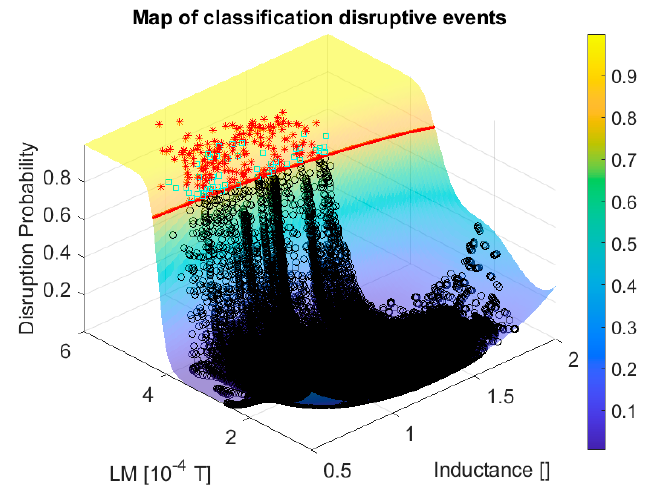
Figure 5. Plot of the safe and disruptive regions of the operational space in JET with the ILW according to the Support Vector Machine (SVM). The colour code represents the posterior probability of the classifier. The black circles are all the non-disruptive shots (10 random time slices for each shot). The red asterisks are the data of the disruptive shots at the time slice when the predictor triggers the alarm. The light blue squares are the false alarms. In red is the 80% disruption probability.